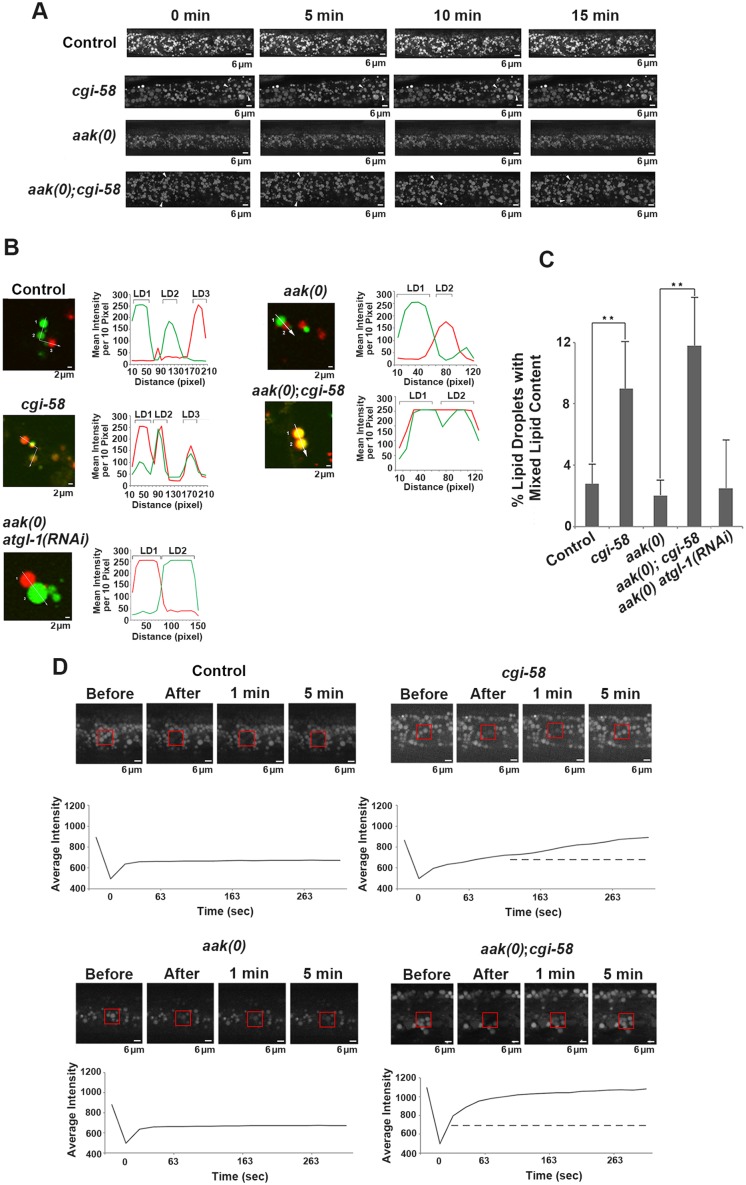
CGI-58 regulates lipid droplet fusion.
(A)
cgi-58 restricts fusion events among lipid droplets in both control and AMPK mutant dauer larvae. Red C1-BODIPY-C12 labeled lipid droplets were imaged in real time (15 min) in control daf-2, daf-2; cgi-58, daf-2; aak(0) or daf-2; aak(0); cgi-58 mutant dauer larvae 32 hours after shifting to restrictive temperature. Scale bar = 6 μm. All strains carry daf-2(e1370) in (A)-(D). (B)
cgi-58, but not atgl-1 limits the exchange of lipid content among lipid droplets isolated from control, CGI-58, AMPK and AMPK; CGI-58 mutant dauer larvae 32 hours after shifting to restrictive temperature. Lipid exchange was determined between isolated Green and Red C1-BODIPY-C12 labeled lipid droplets mixed in vitro for 30 minutes, following which fluorescence of individual droplets was analysed. Longer incubation times were performed and similar results were obtained. The abundance of lipid droplets/ml reaction volume was adjusted to similar levels prior to quantification. LD1 and LD2 represent two individual differentially labelled lipid droplets. The line graph at the right side of each set of images represents the fluorescent intensity of Green and Red C1-BODIPY-C12 labeled lipid droplets along the white arrow. Scale bar = 2 μm. (C) Quantification of the lipid droplets containing both green and red labelled lipid contents (both red and green fluorescent intensities are greater than 100) derived from the droplets described in (B) determined for 1000 lipid droplets analyzed for each respective genotype. ** indicates statistical significance (P<0.01). (D) Lipid content was more rapidly replenished in droplets obtained from animals that lack CGI-58. The dotted line in the graphs of the second (cgi-58) and fourth (aak(0); cgi-58) panel represent the maximum recovered intensity observed in the graph of the first (control daf-2) and third (aak(0)) panel. FRAP analysis was performed on control daf-2, daf-2; cgi-58, daf-2; aak(0) or daf-2; aak(0); cgi-58 dauer day 0 animals. Raw imaging data were captured and processed using Metamorph image acquisition software. Scale bar = 4 μm.